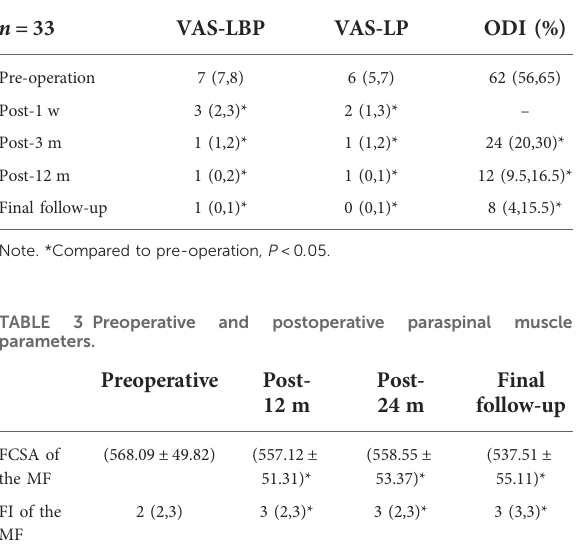
TABLE 4 Preoperative and postoperative scores of the segment facet